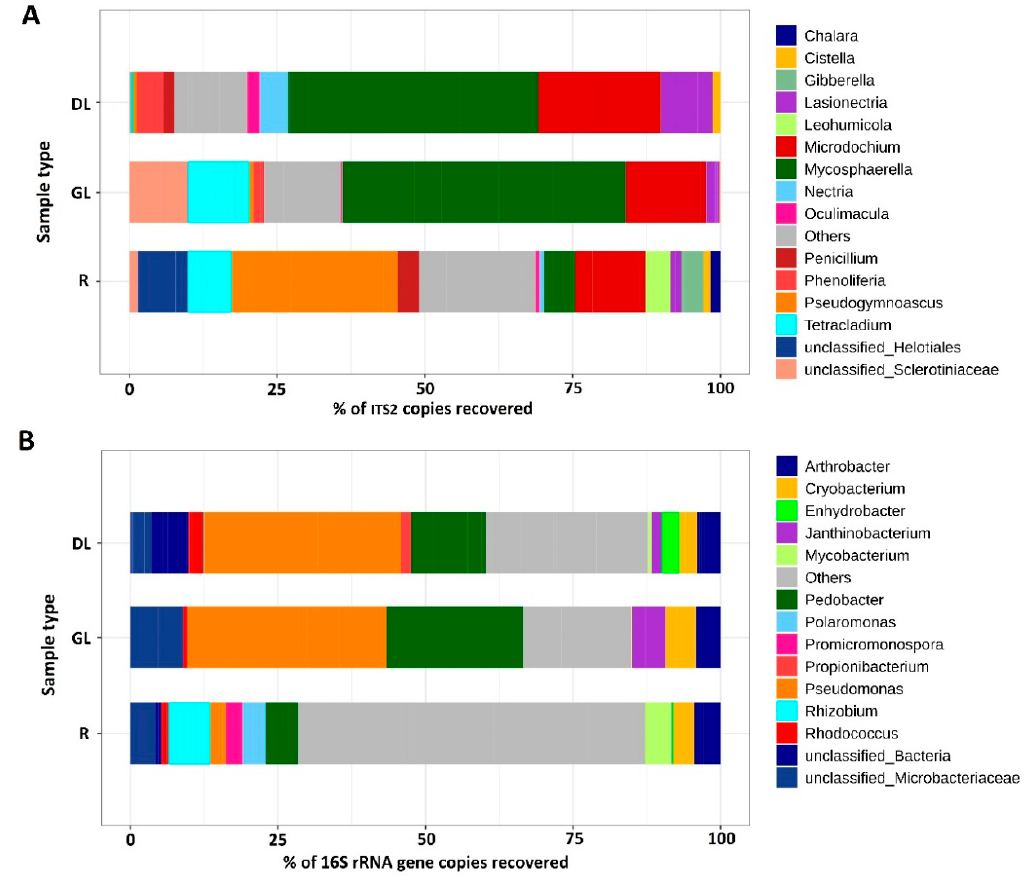
Figure 4. The taxonomy composition of the fungal ( A ) and bacterial ( B ) communities of winter rye plants affected by the snow mold disease. Desiccated dead parts of leaves (DL), green parts of leaves (GL), and roots (R) were analyzed separately. Each color represents a relative abundance of the particular fungal or bacterial genus in the samples. The genera with the abundance of ≥ 10% in at least one of the analyzed samples are presented; the other genera are merged into the category “others”. The relative abundance of the particular genus was determined by calculating the percentage of genus-corresponding OTUs in fungal/bacteria datasets.